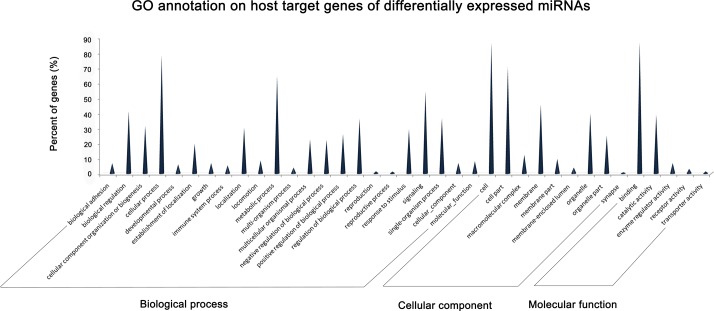
GO annotation of host target genes of differentially expressed miRNAs.GO functional analysis using the DAVID web-based tool shows that a series of targets belong to a series of functional genes involved in cellular process, metabolic process, and immune system process, which indicated the potential regulatory role of the differentially expressed miRNAs in viral infection. For other enriched GO terms, please see S4 Table.